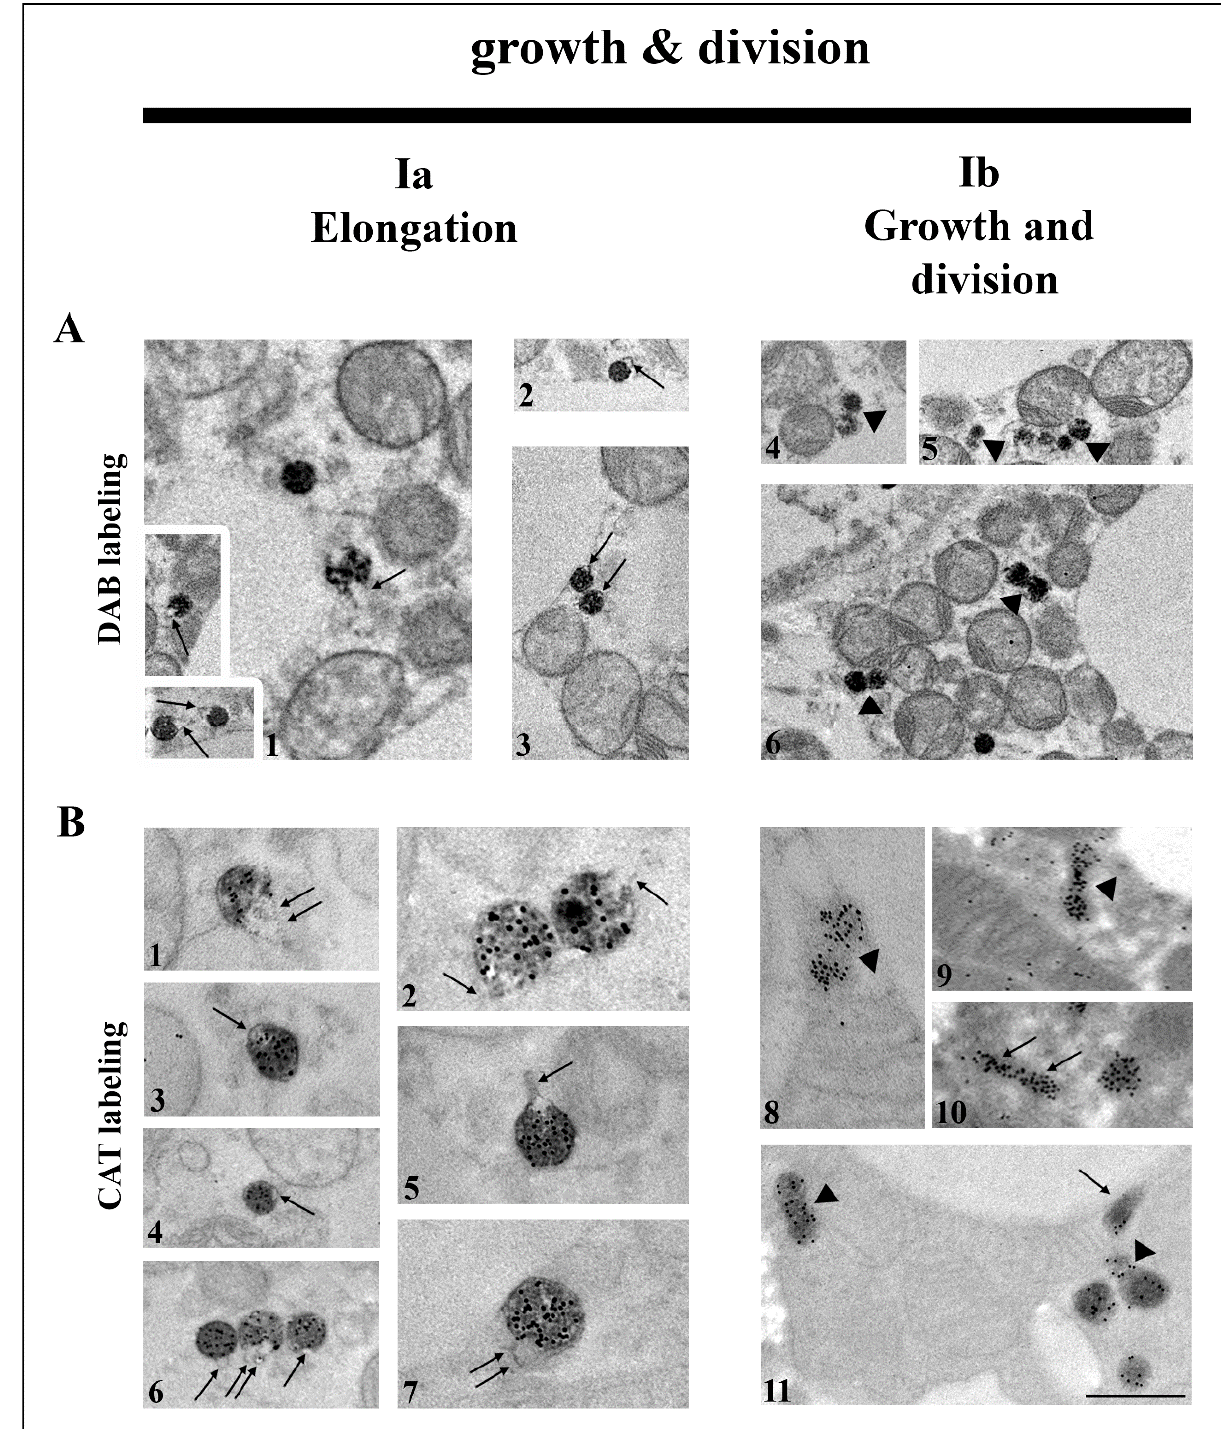
Figure 2. Canonic pathway of peroxisomal biogenesis through growth and division in brown adipocytes. Representative electron micrographs from both euthyroid and hypothyroid groups with DAB-labelled ( A ) and CAT-labelled ( B ) peroxisomes. This multistep pathway of biogenesis starts with the formation of membrane protrusions at spherical peroxisomes—the peroxisomal noses ( A 1–3, B 3,4—arrows). Further elongation of noses ( B 1,2,5,6,7—arrows) leads to the formation of tubular structures ( B 10,11—arrows), which is supported by the import of new peroxisomal membrane proteins and lipids. The following step is the peroxisomal membrane constriction (segmentation of the membrane compartment) and forming dumbbell-like structures ( A 4,5,6, and B 8,9,11—arrowheads), which leads to final division. Original magnification 17,000 × and 22,000 × ( B 2,5,7). Scale bar 1 µ